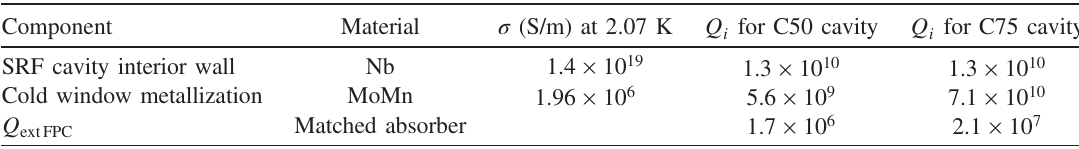
TABLE III. Numerically computed Q values of individual components as present in a C50 and C75 cavity in the CM configuration with plunger positions (0,0,0). There was no discernable difference in the total volumetric rf losses whether or not the dielectric losses were included as part of the computation.